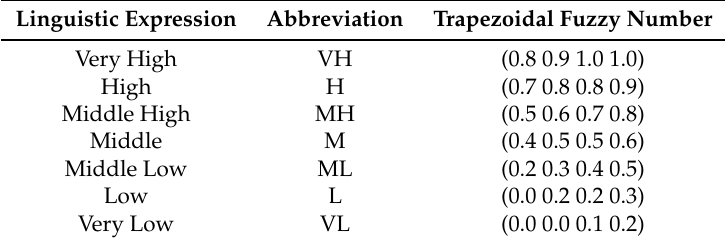
Table 2. Linguistic variables for priorities of each criterion.